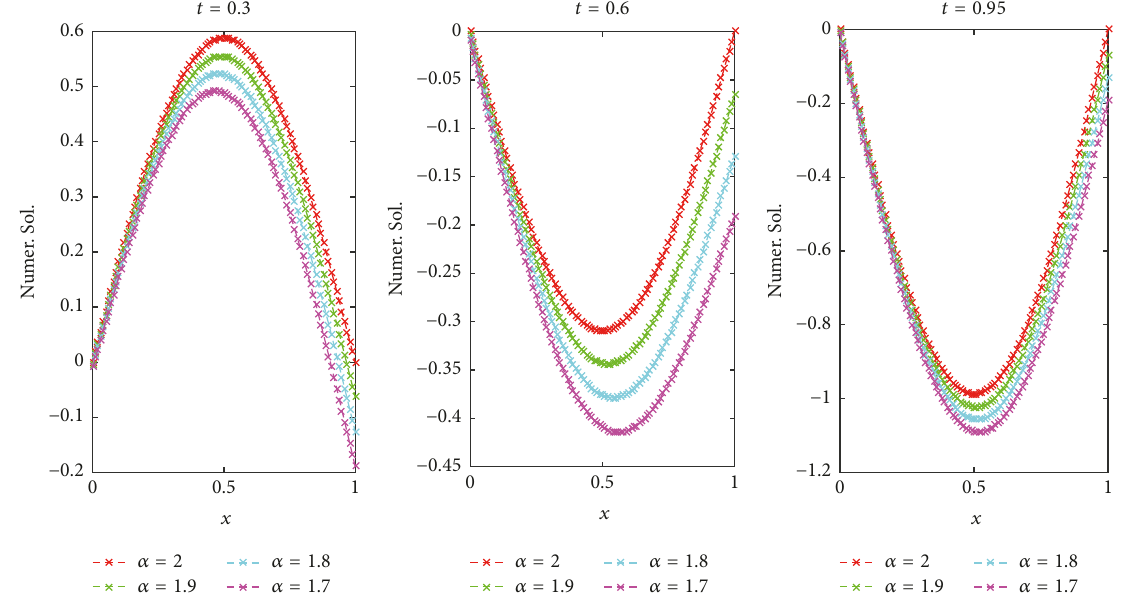
Figure 10: The numerical solutions with 𝛼 = 2,1.9, 1.8, 1.7 when 𝑘 = 𝑀 = 4